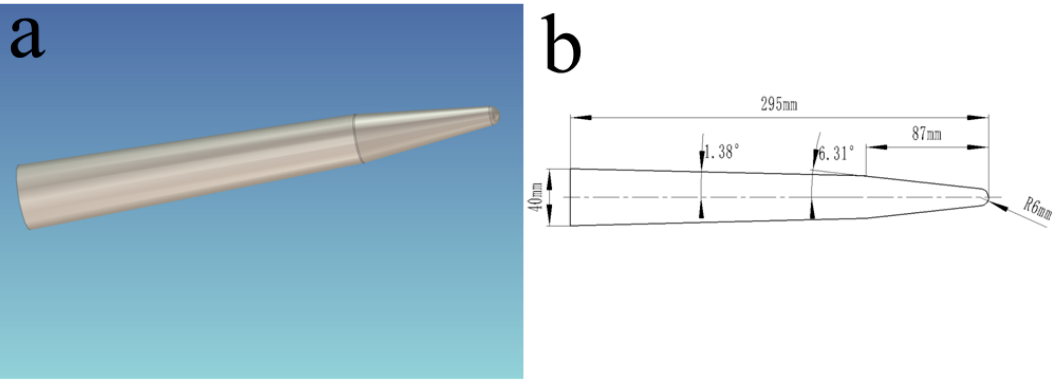
Figure 2. ( a ) The three-dimensional drawing and ( b ) the two-dimensional drawing of the hypersonic flying